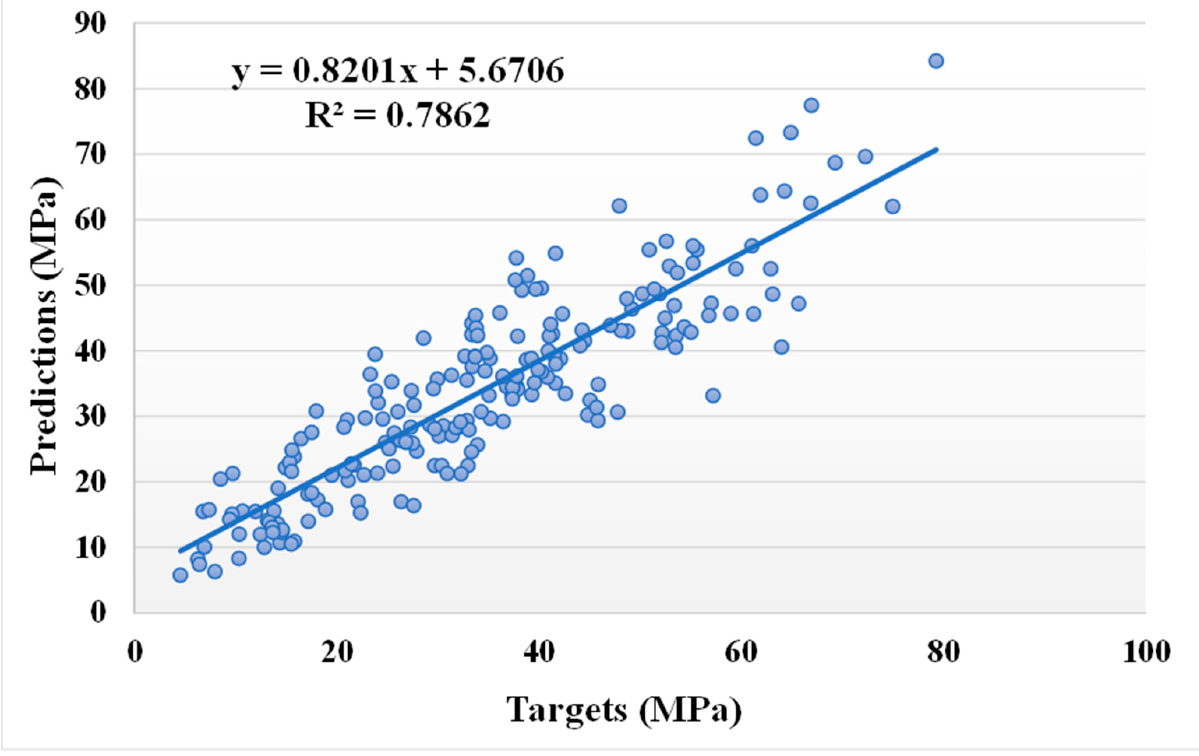
Figure 9. Relationship between the actual and predicted results of the DT model.